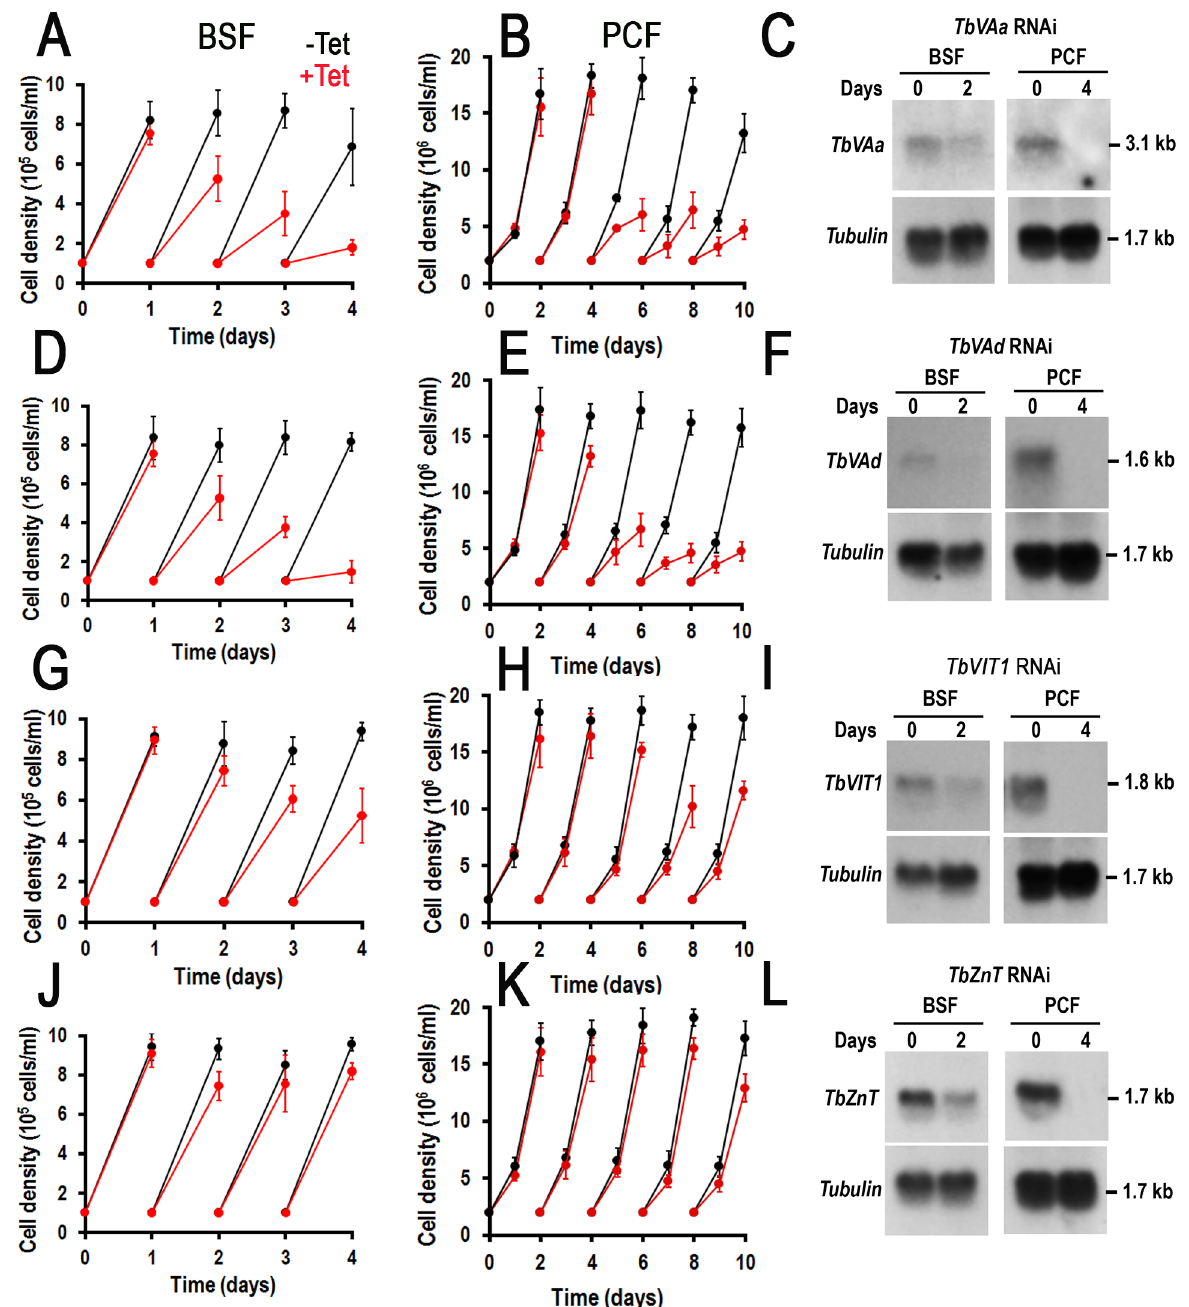
Fig. 6. Effect of inhibition of expression of four acidocalcisome genes by tetracycline-induced RNAi on cell growth. (A–B), (D–E), (G–I), and (J–L) show growth of BSF ( left panels ) and PCF ( right panels ) trypanosomes of TbVAa , TbVAd , TbVIT1 , and TbZnT RNAi in the absence ( 2 Tet , black lines ) or presence ( + Tet , red lines ) of 1 m g/ml tetracycline for the indicated number of days, respectively. Values are means 6 SD (n=3–4). (C), (F), (I) and (L) show northern blot analyses of TbVAa , TbVAd , TbVIT1 , and TbZnT RNAi in the absence (0) or presence (2 or 4 days) of tetracycline, respectively. Tubulin is shown as a loading control. Markers are shown on the right .